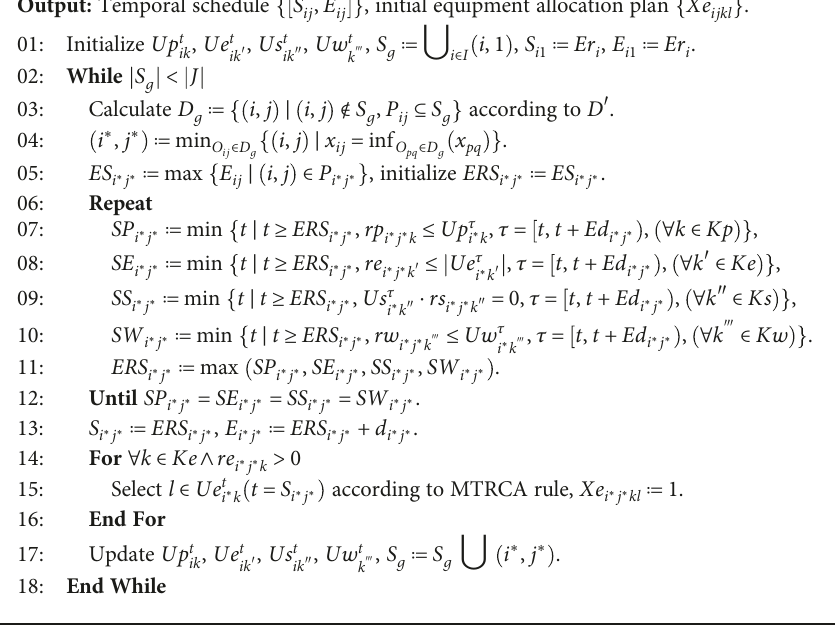
Algorithm 1: Algorithm of serial schedule generation scheme for aircraft deck